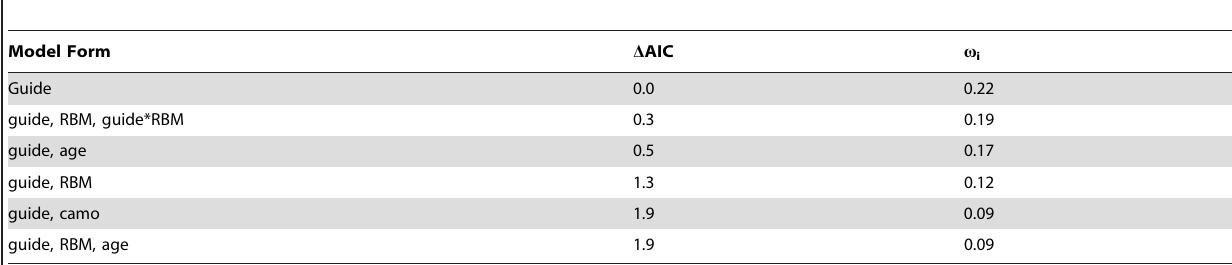
Table 1. Top Models ( D AIC # 2) to predict the odds of wildlife hunters killing large cervids in British Columbia and Alberta, Canada.